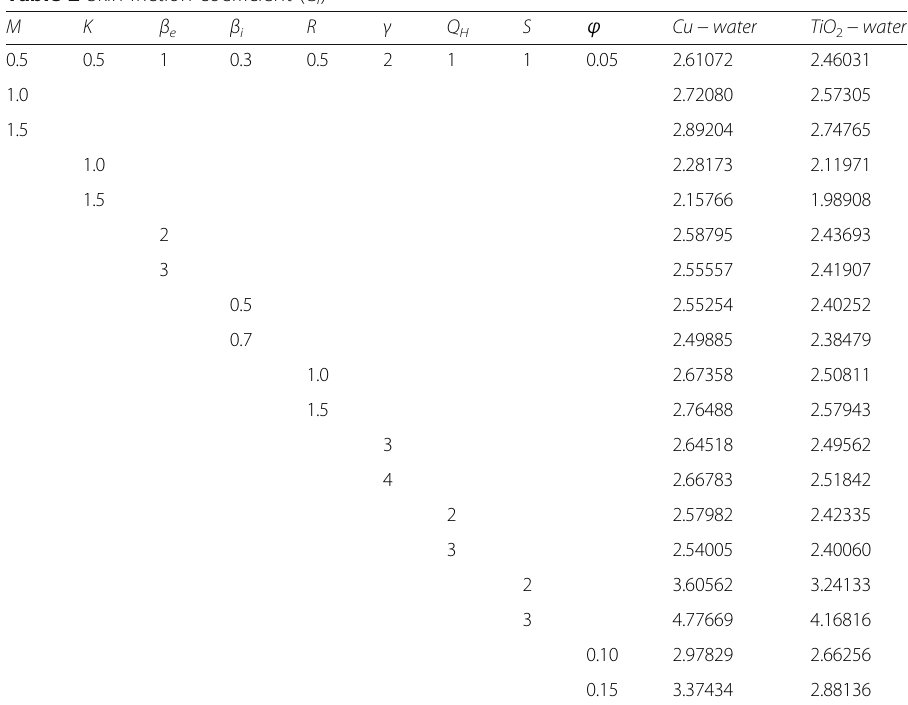
Table 2 Skin friction coefficient ( C f